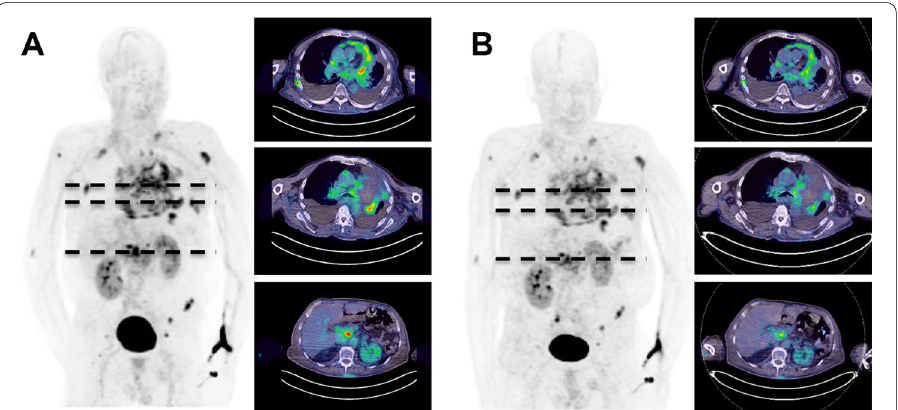
Fig. 4 Whole body PET/CT images of a 68y old patient with NSCLC in the left upper lobe. Shown are the maximum intensity projections and transaxial cuts at A 1 h and B 3 h after administration of 323 MBq [ 18 F]